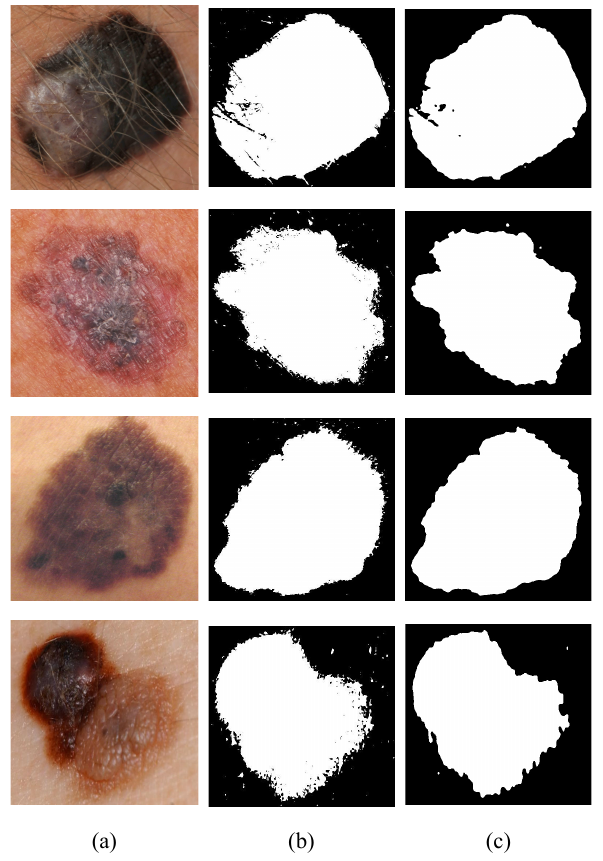
Figure 4. Removal of skin and noise from the original image. ( a ) original image, ( b ) results obtained after applying the Gaussian filter, ( c ) final results obtained after applying mathematical